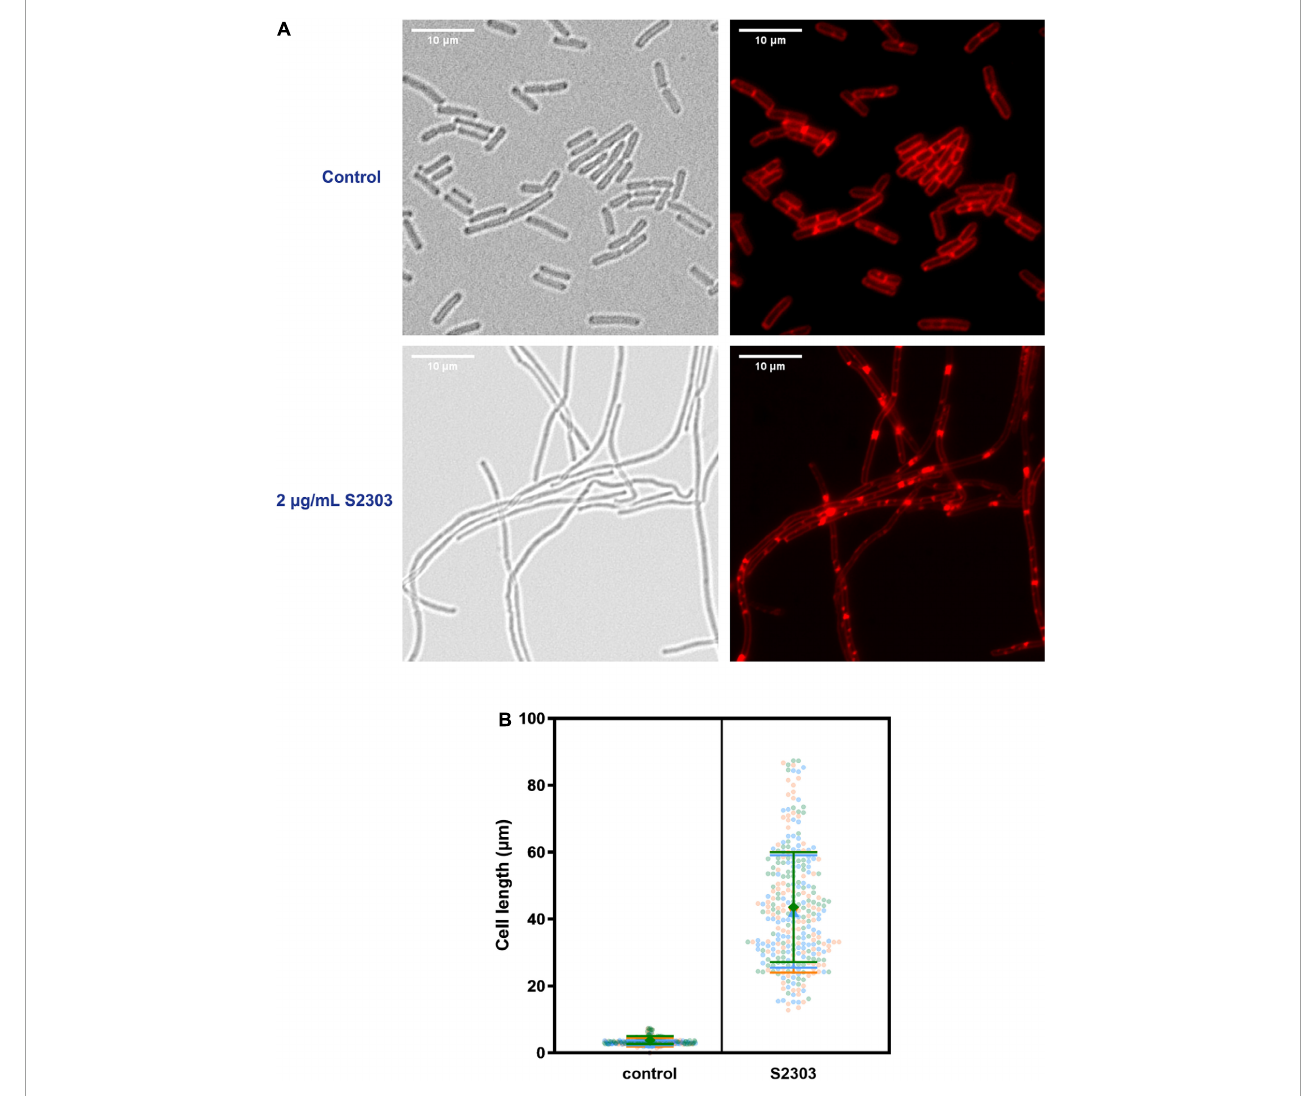
FIGURE2 Elongation of Bacillus subtilis cell morphology was observed in cells treated by S2303. (A) Representative images of cells (OD 600 = 0.01) treated with 1% (v/v) Dimethyl sulfoxide (DMSO) and 2 µ g/mL S2303 were collected using a Nikon Ti2-E microscope. Cells were stained with FM 4-64 to mark the outline of the cells. There is a homogenous population of cells with short rod morphologies in cells treated with DMSO and a homogeneous population of cell filaments in cells treated with 2 µ g/mL S2303. (B) The scale bar is 10 µ m. In each of the three independent experiments, 100 cells of cells treated with 1% (v/v) DMSO and 2 µ g/mL S2303 are randomly selected and measured using ImageJ and plotted using GraphPad. In each super plot, the middle large data points represent the median of the cell lengths of different replicates while two lines represent the corresponding standard deviation. The results of each experiment are plotted in a different